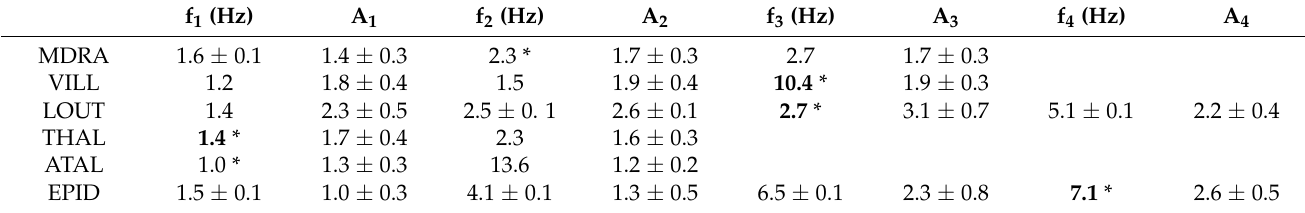
Table A1. Observed peak frequencies (f i ) and associated amplification factors (A i ). Values marked with an asterisk (*) correspond to the dominant peak frequency, f p (highest amplification). The adapted fundamental frequencies, f 0 , (Table 5) are indicated in